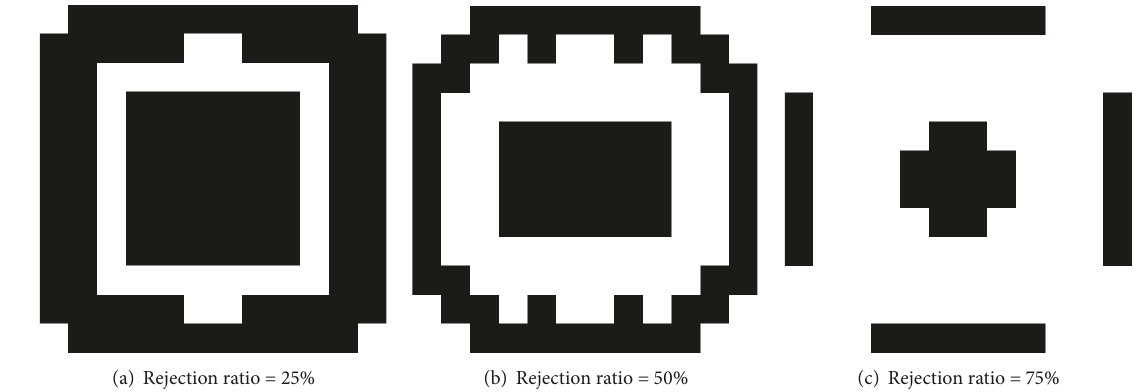
Figure 19: Optimal layouts of CLD treatments under exciting force at point 1 for second BC.